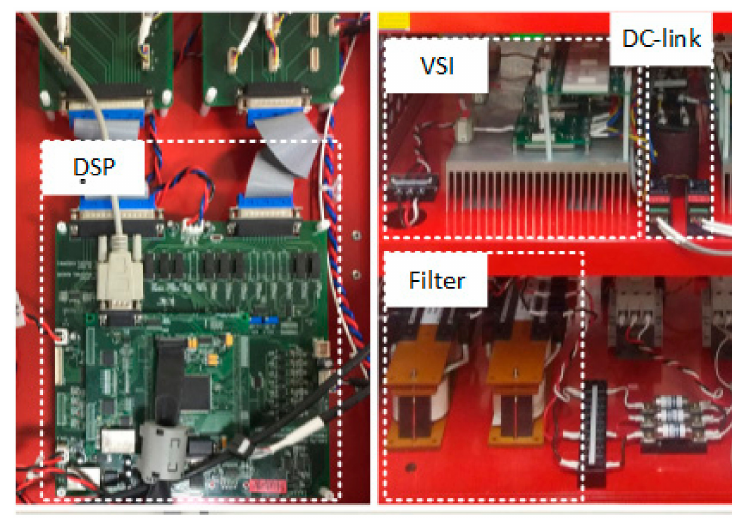
Figure 11. Experimental setup.